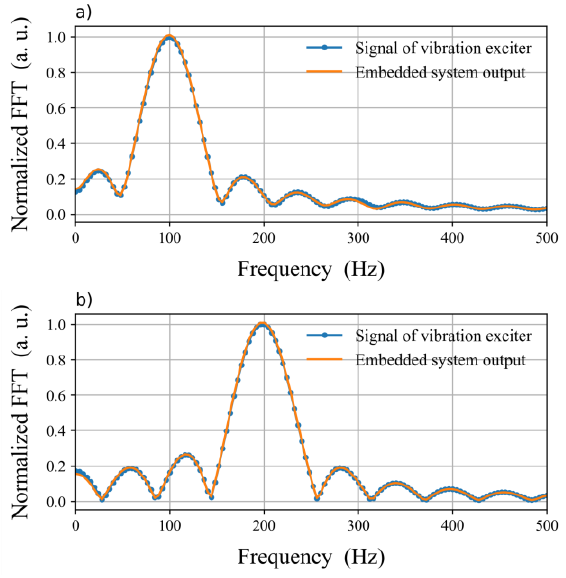
Figure 9. FFT (magnitude) comparison of embedded system output and shaker signal corresponding to Figures 7b and 8. ( a ) For ω = 2 π × 100. ( b ) For ω = 2 π × 200.